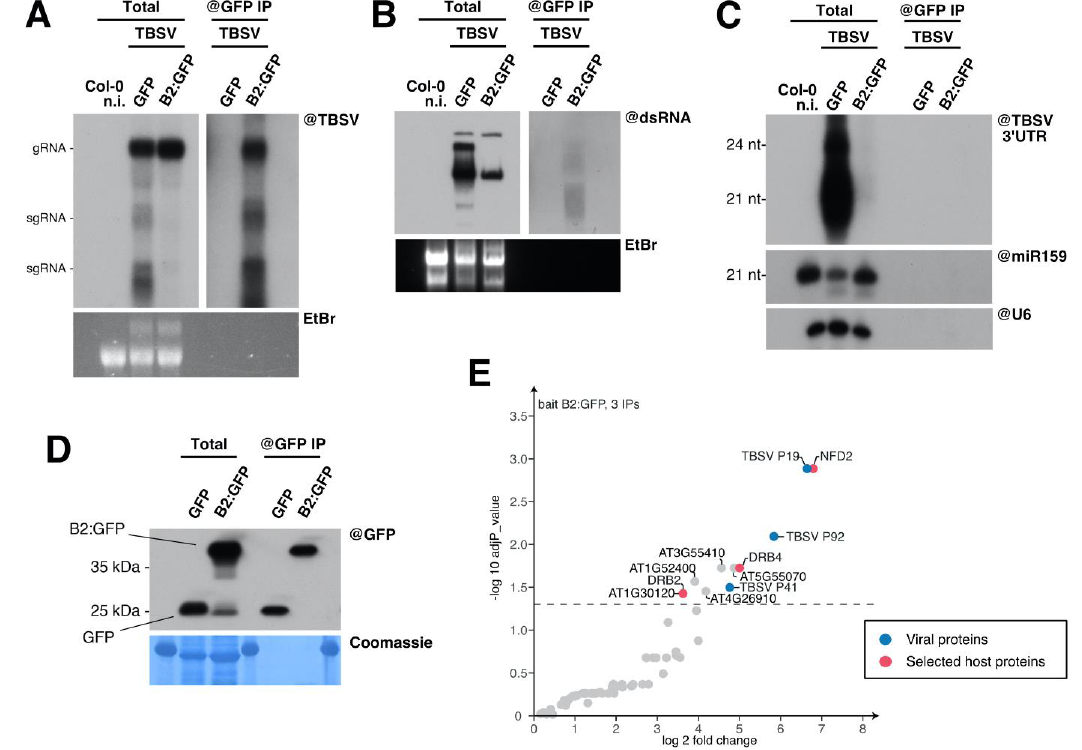
Figure 3. Immunocapture of TBSV dsRNA and associated proteins. ( A ) Northern blot analysis of high molecular weight RNA to detect TBSV genomic RNA. RNA was extracted from total (left) and anti-GFP immunoprecipitated (right) fractions of 35S: GFP and 35S: B2:GFP / Col-0 A. thaliana systemically infected with TBSV. A non-infected Col-0 control was included among the total fractions, to the far left. ( B ) Northwestern blot analysis of the RNA samples described in ( A ), size-separated on a non-denaturing agarose gel, to detect double-stranded RNA through recombinant B2-Strep. In ( A ) and ( B ) ethidium bromide staining of the gels was used as loading control. ( C ) Northern blot analysis of low molecular weight RNA from the samples described in ( A ), to detect TBSV-derived siRNA. As loading control, the same membrane was separately hybridized to probes specific to miR159 and snU6. ( D ) Western blot analysis of proteins from the samples described in ( A ) to detect GFP. Here, the non-infected Col-0 present in ( A – C ) was not included. ( E ) Volcano plot representation shows the enrichment of proteins from TBSV-infected plants that co-purified with B2:GFP. Y - and X -axis display adjusted p -values and fold changes, respectively. The dashed line indicates the threshold above which proteins are significantly enriched (adjP < 0.05). The source data are available in Supplementary Table